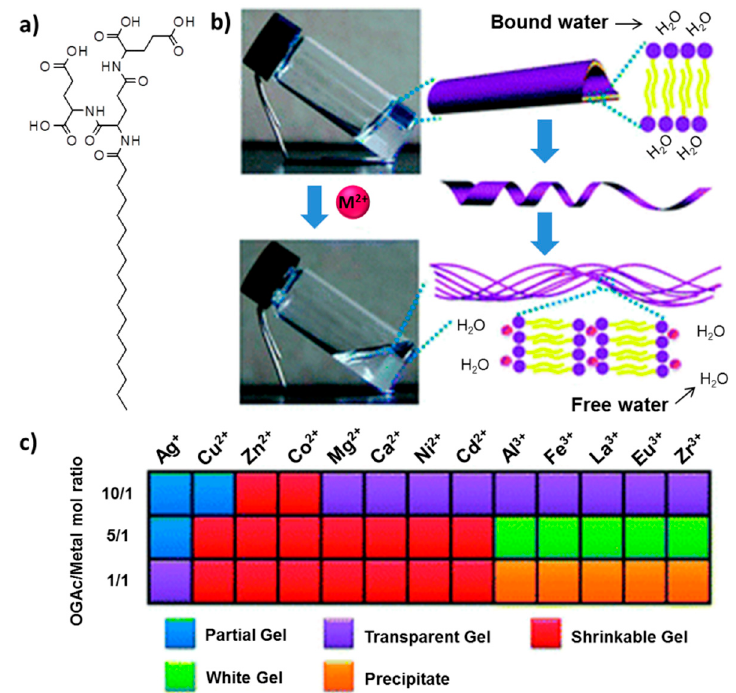
Figure 4. ( a ) Structure of the hydrogelator (OGAc); ( b ) metal ion-triggered shrinkage of the supramolecular hydrogel; ( c ) effect of metal ions on the gelation properties. Adapted from [17] with permission of The Royal Society of Chemistry.